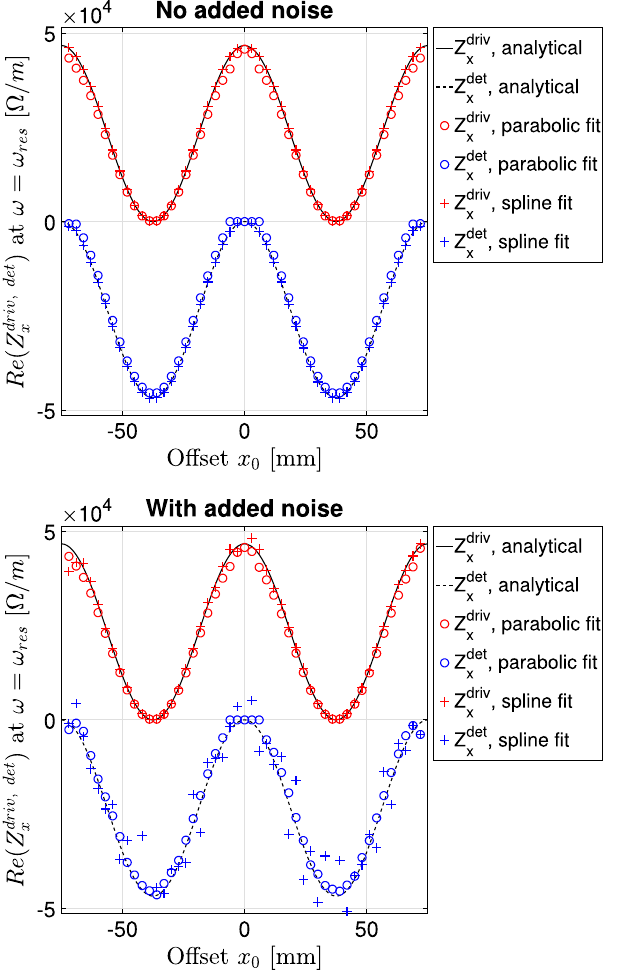
FIG. 5. Top: The considered roman pot cavity (courtesy: Nicola Minafra). The vacuum region is shown in grey. No ferrite absorbers are considered. The electric field of the chosen mode is shown with arrows. Bottom: f ð y Þ ≡ ð R=Q Þ jj of the selected mode as a function of the vertical coordinate y